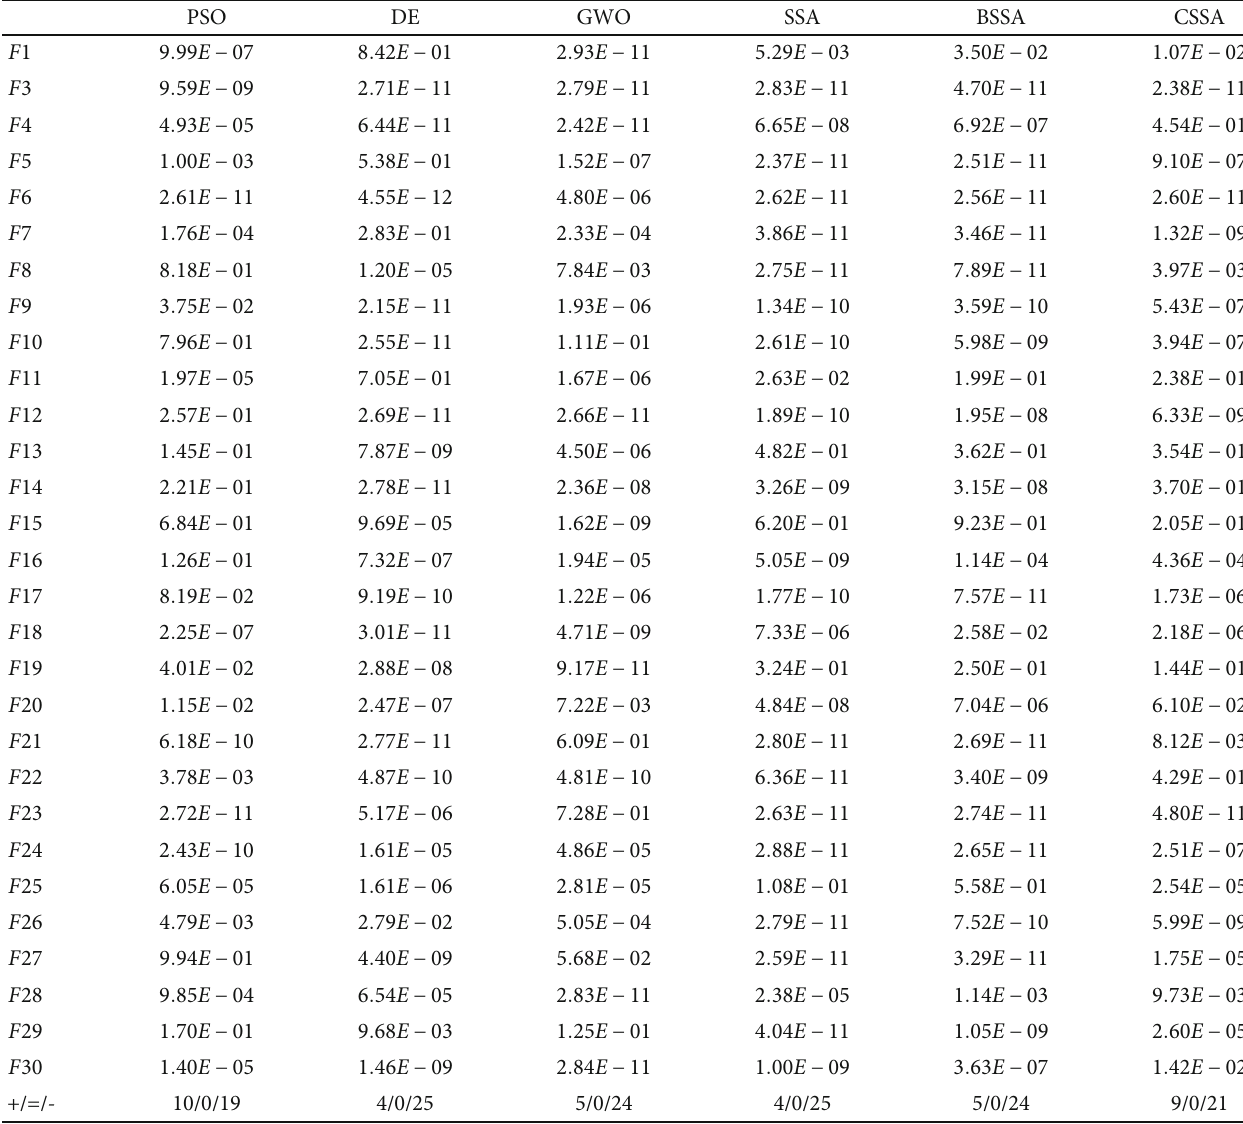
Table 5: Wilcoxon rank sum test.